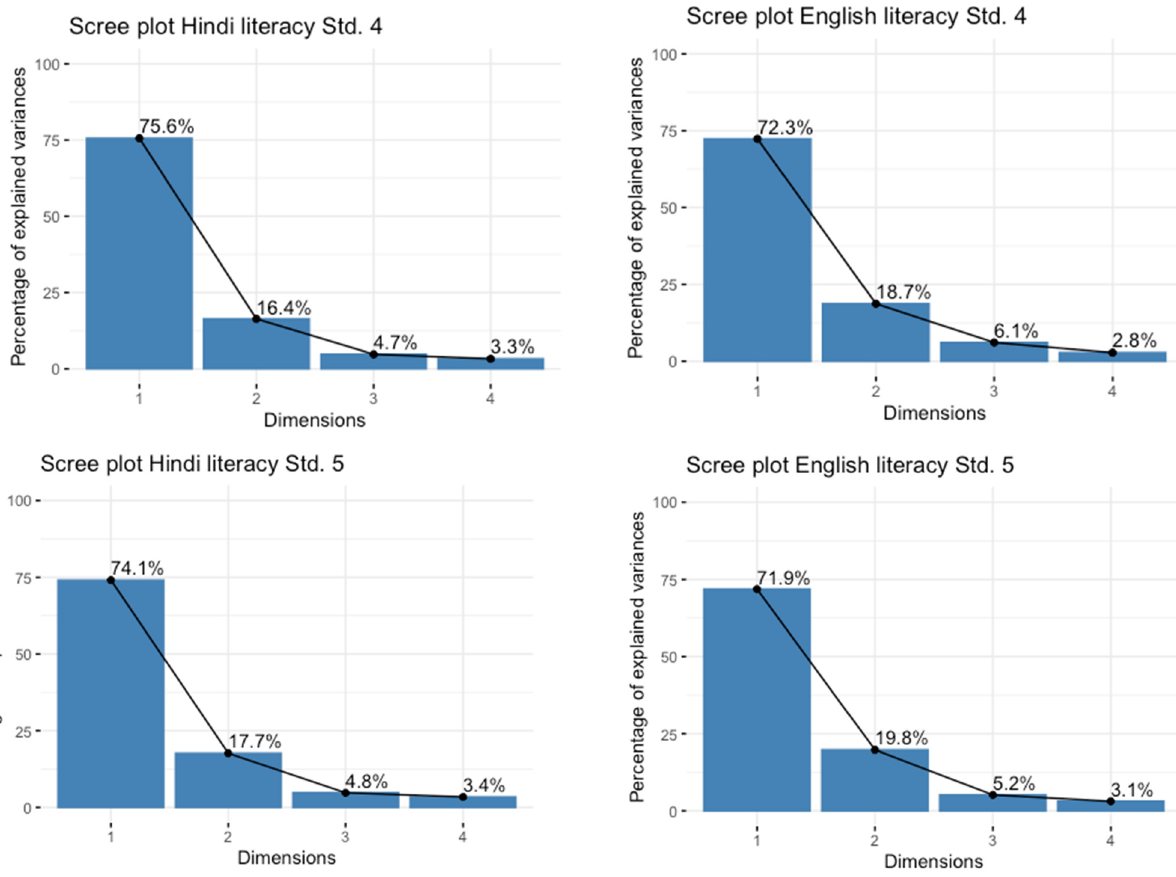
Figure A1. Scree plots of the principal components analyses for the literacy data.